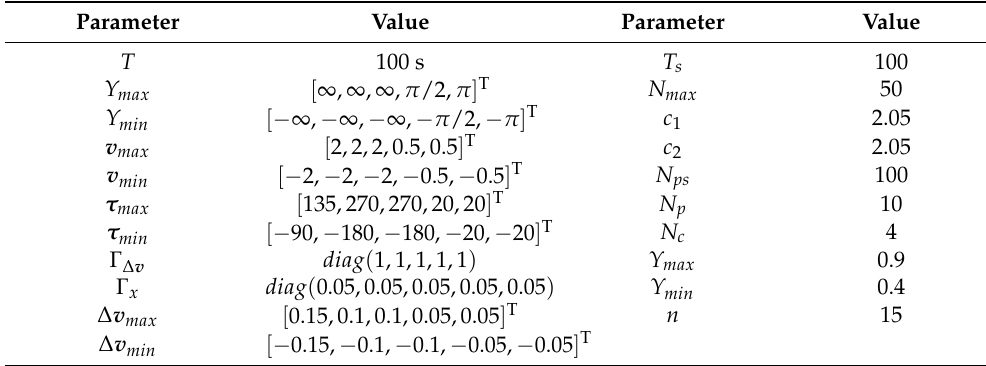
Table 2. Simulation parameters.